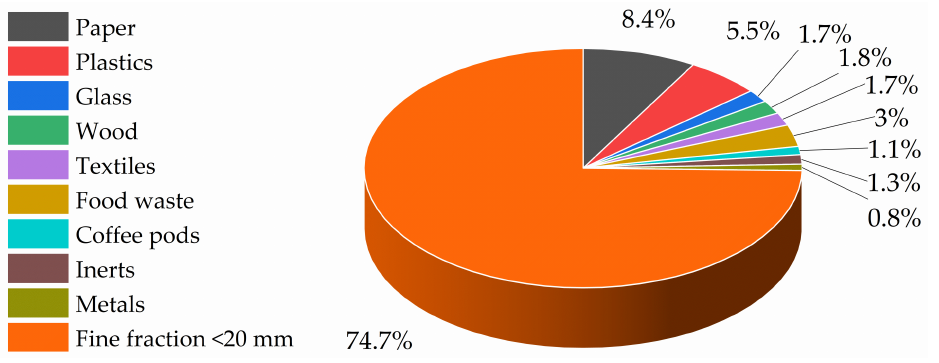
Figure 2. Composition of under-sieve fraction of municipal mixed waste